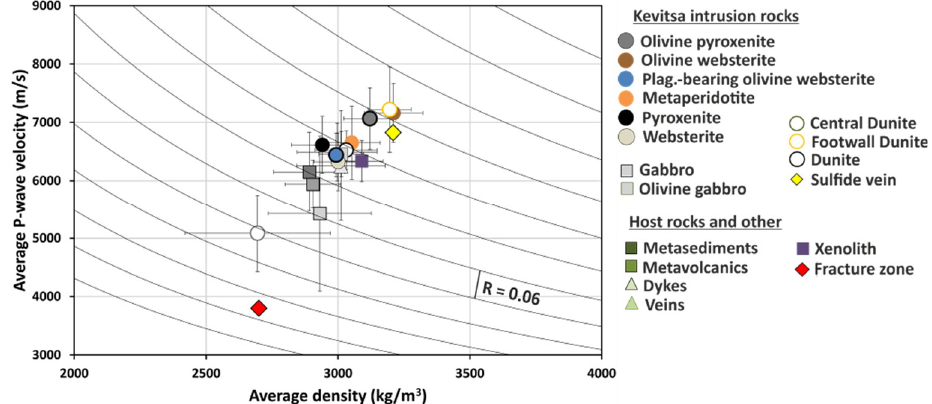
Figure 4. Average P-wave velocities versus densities plotted for the different lithologies observed in the Kevitsa borehole data. Error bars represent standard deviation. The black curves correspond to constant acoustic impedance. The difference between two curves is equal to a reflection coefficient of 6% that should be enough for a detectable reflection [28,29]. The difference between the physical properties of plagioclase-bearing olivine websterite (blue dot) and olivine pyroxenite (grey dot) seems to be enough to produce a detectable reflection.